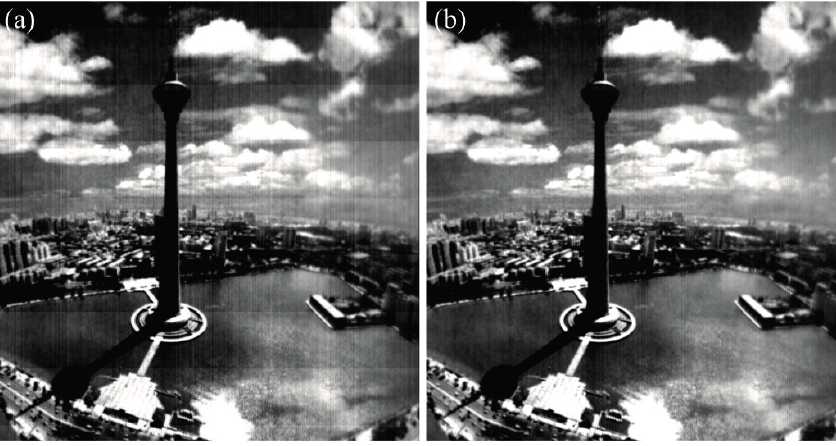
Figure 16. Comparison of visual effect of the Dubai International Airport. ( a ) Original image; ( b ) Corrected image.